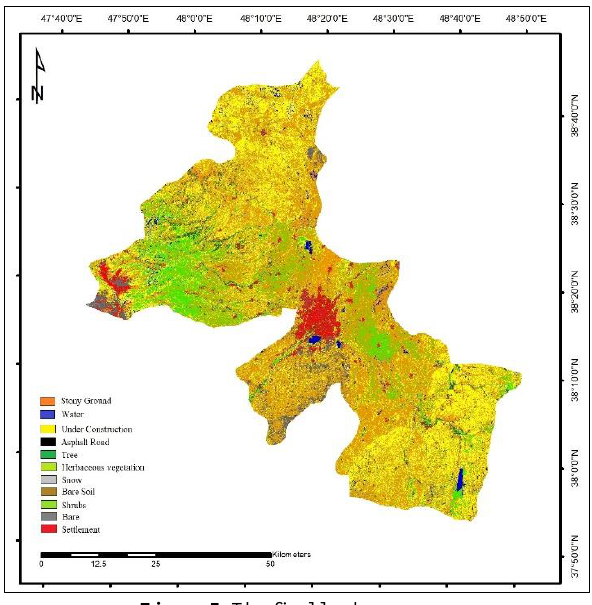
Figure 5. The final land use